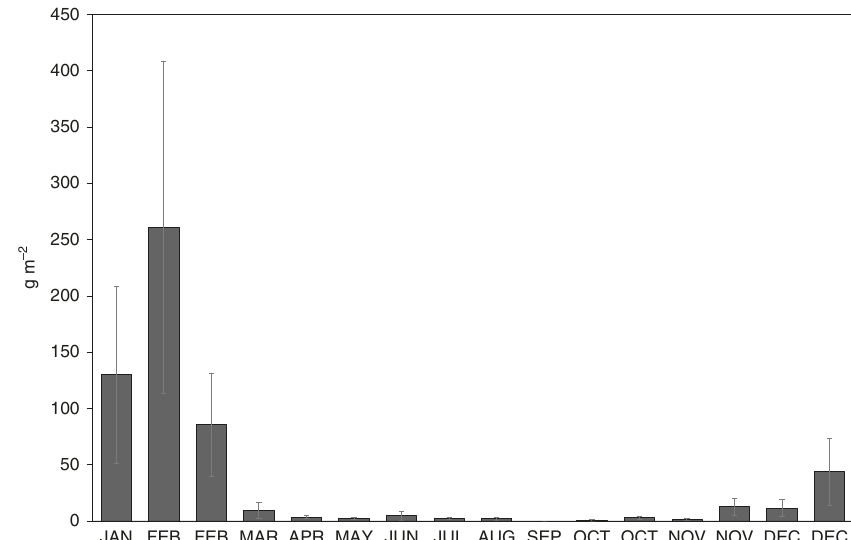
Fig. 4 Biomass of krill population. Mean biomass (wet weight) of krill (g m − 2 , ±1 SD) from each sediment trap bottle period based on an inverse model calculation based on exuviae caught in the sediment